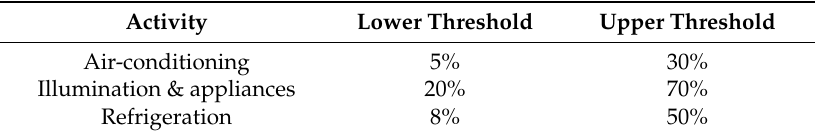
Table 7. Minimum and maximum level of penetration of use of efficient appliances and/or decrease of their time of use for the Mexican residential